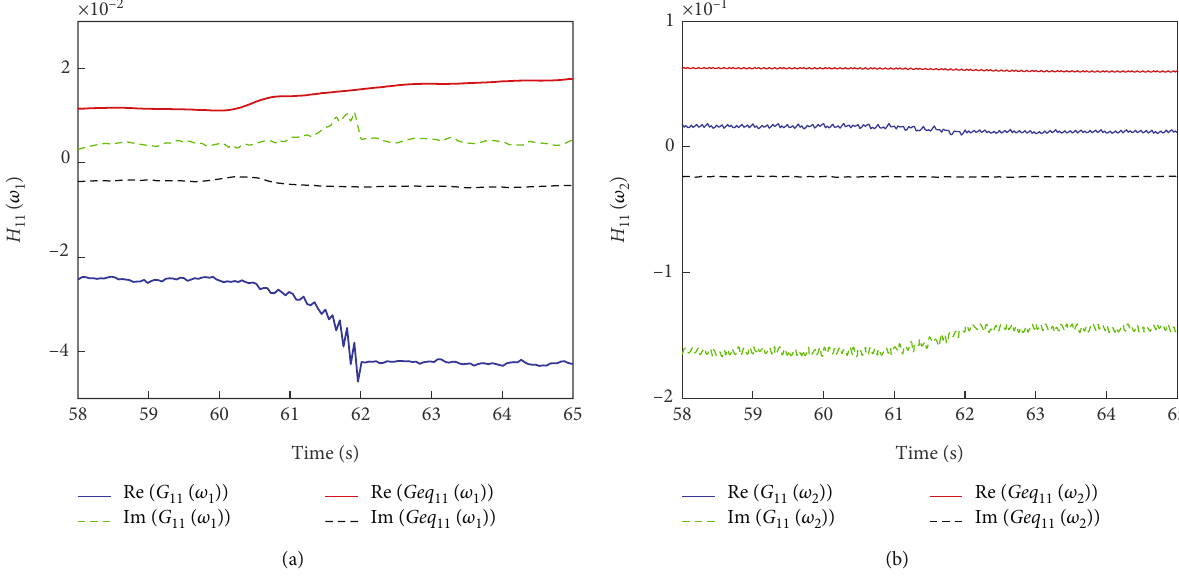
ð ω Þ before and after system parameter mutation (58-65s). (a) 11